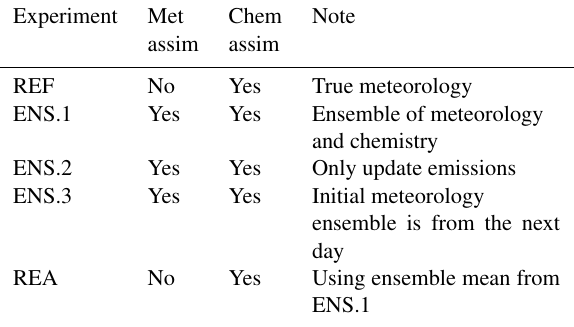
Table 1. The experimental setup of each assimilation run. The three ensemble runs assimilate NO 2 observations every hour and differ in treatment of meteorology forecast.